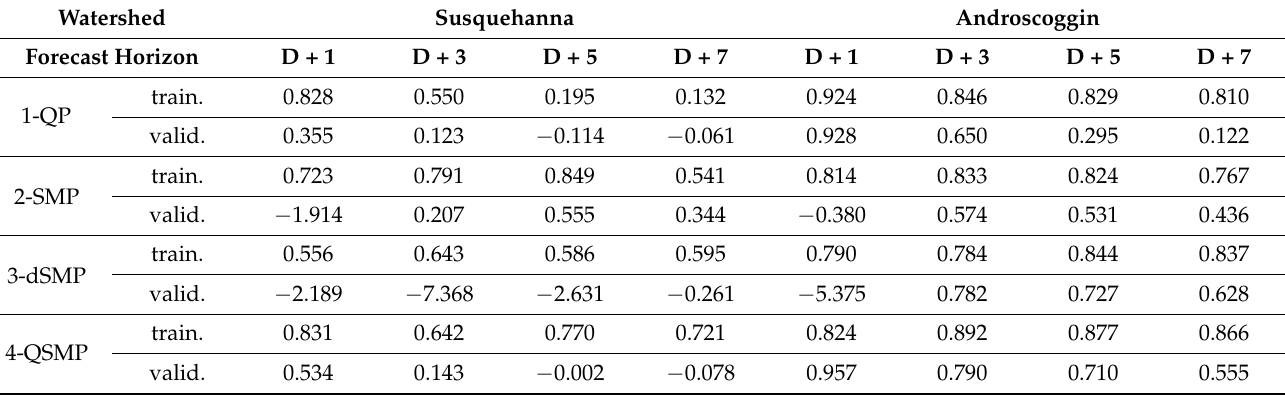
Table 6. NSE values for Susquehanna and Androscoggin for summer 2010, a relatively dry year as validation